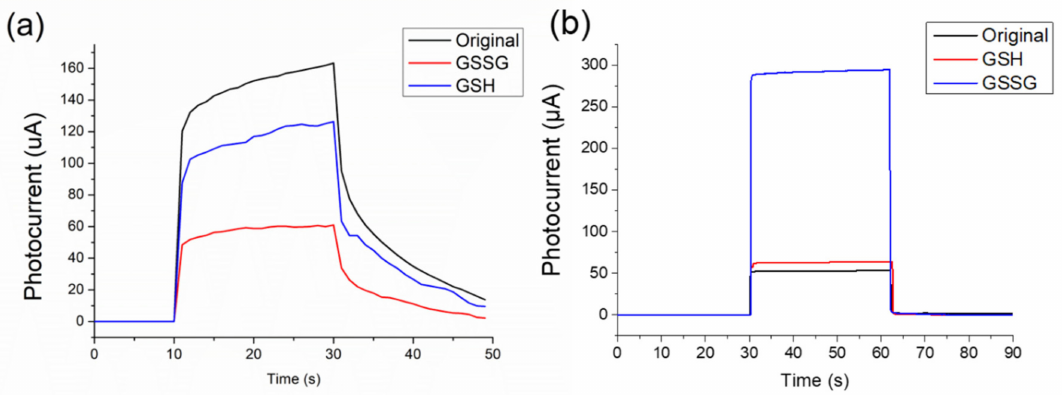
Figure 6. Sensitivity analysis of ( a ) light response of P-type element to GSH/GSSG and ( b ) light response of N-type element to